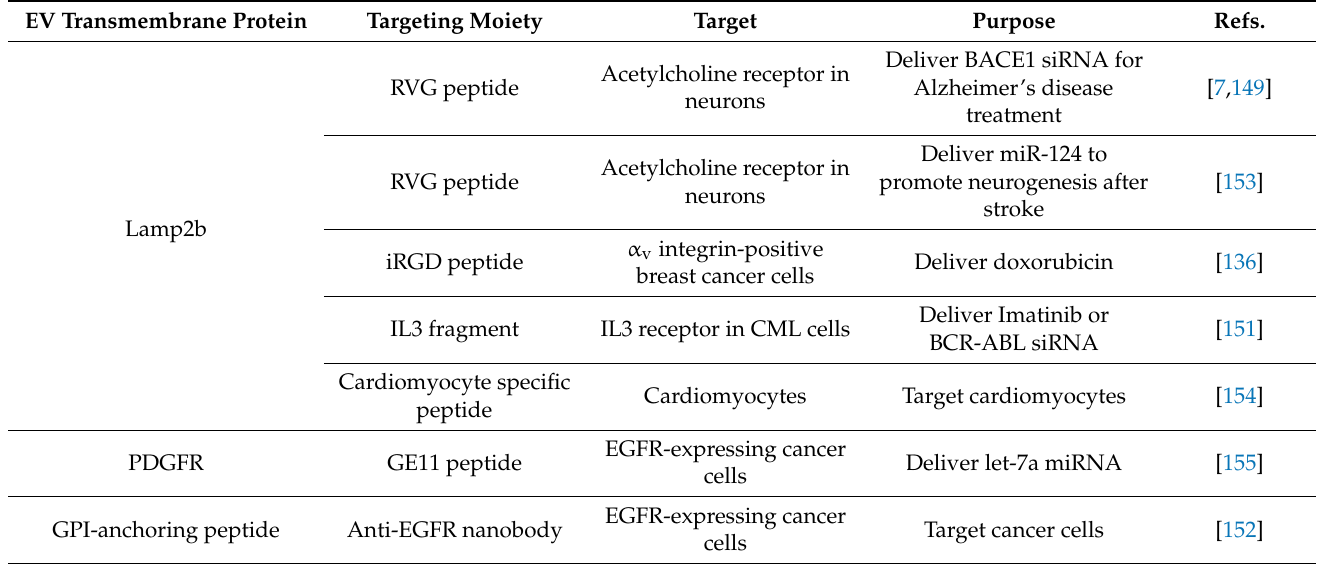
Table 1. Overview of strategies to engineer targeting of extracellular vesicles (EVs) through genetic modification of producing cells to express a targeting moiety fused to an EV transmembrane protein.